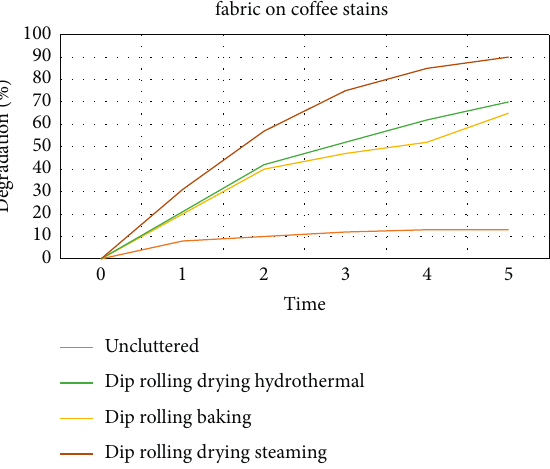
Figure 5: Self-cleaning effect of nano-TiO red wine and coffee